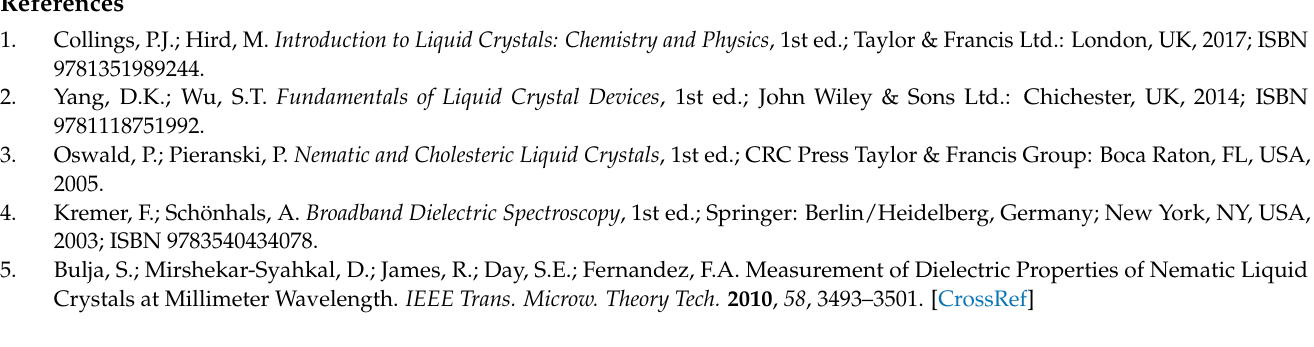
Supplementary Materials: Figure S1: Relative permittivity of three purified LC mixtures as a function of frequency. Measurements were taken at 1 V and room temperature (20 °C) using 20 µm cells in homogeneous and homeotropic alignments. P stands for purified LC mixtures.